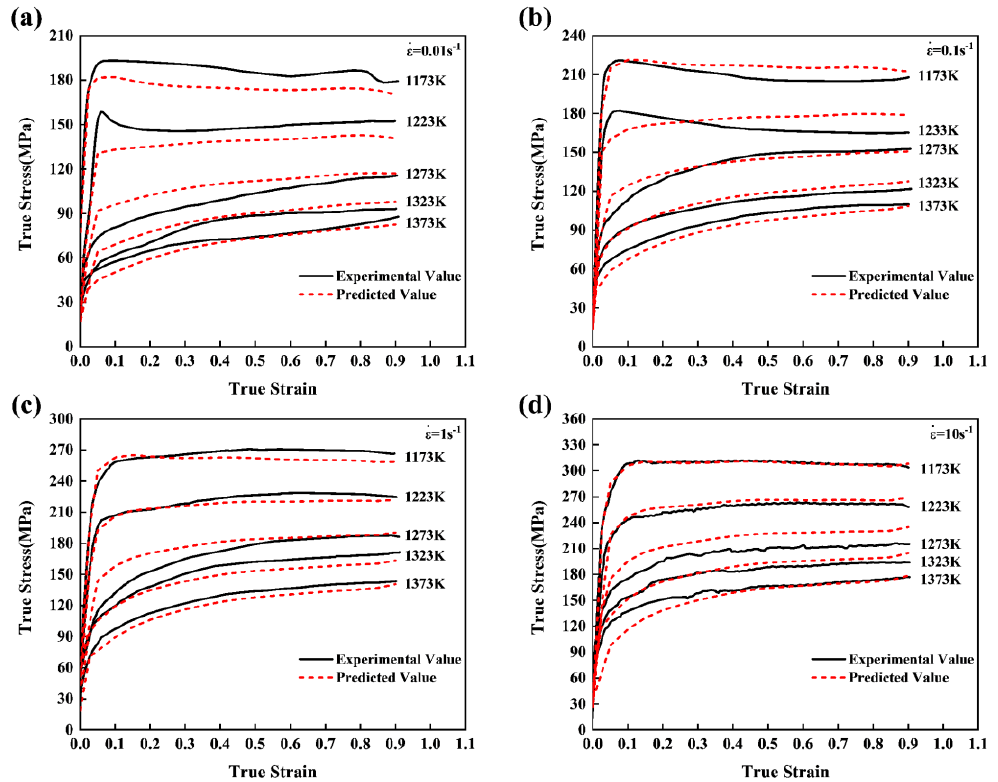
Figure 6. Comparison of predicted and experimental true stress-strain curves. ( a ) 0.01 s −1 ; ( b ) 0.1 s −1 ; ( c ) 1 s −1 ; ( d ) 10 s −1 .